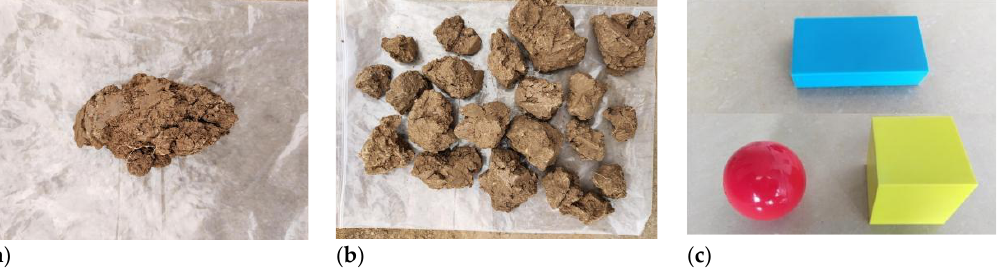
Figure 1. Acquire Image. ( a ) Individual soil blocks. ( b ) Cohesive soil blocks. ( c ) Reference objects.